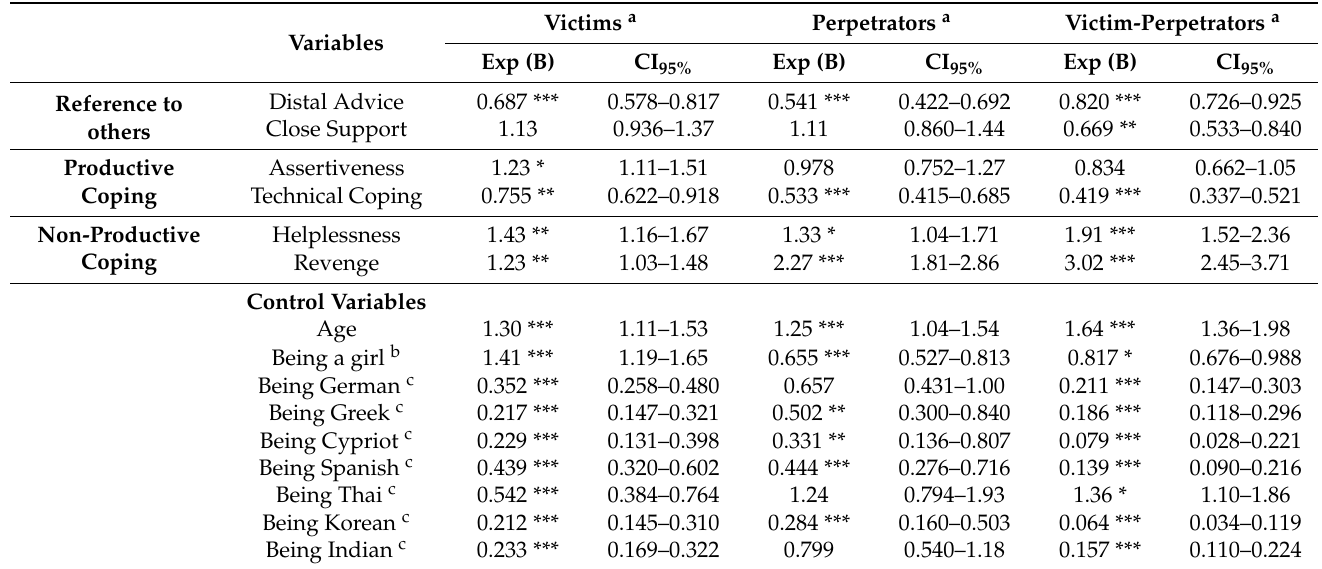
Table 3. Results of Coping Strategies Predicting Involvement in Cyberhate as Victim, Perpetrator, or